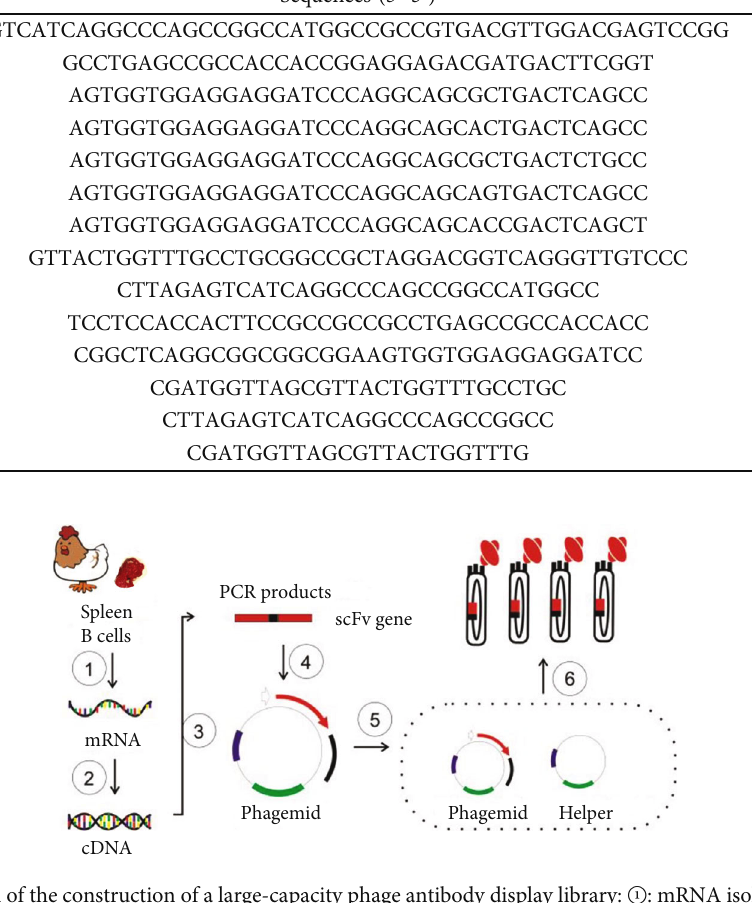
Table 1: The primers used in the construction of the phage display hen scFv library. Sequences (5 ′ -3 ′ )